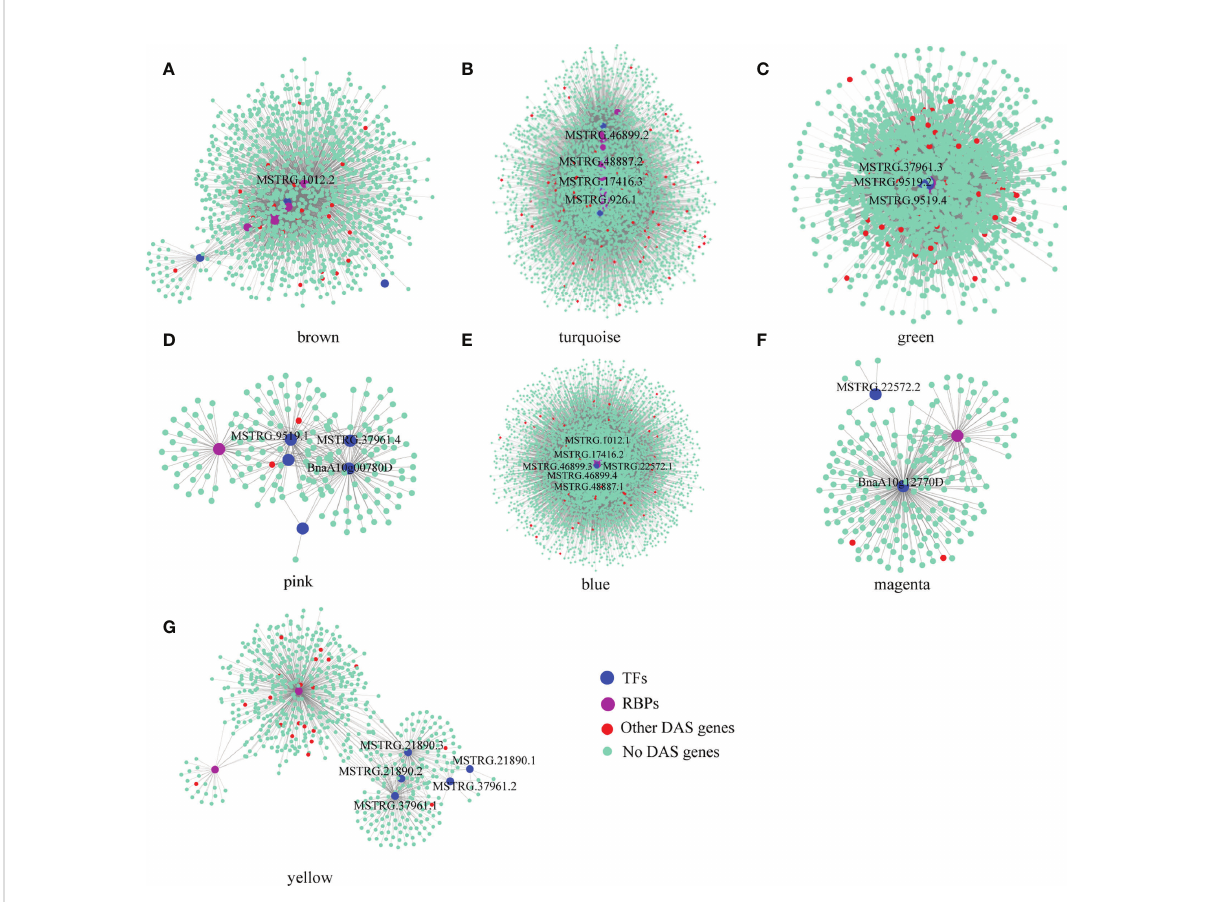
FIGURE 4 Visualization of the stress-related co-expression networks by Cytoscape. Panels (A – G) , respectively, represented brown, turquoise, green, pink, blue, magenta, and yellow module. Using Cytoscape, the purple nodes represent the isoforms of the RBPs of DAS genes, the blue nodes represent the isoforms of TFs of DAS genes, the red nodes represent the isoforms of other DAS genes, and the light blue nodes represent other connected